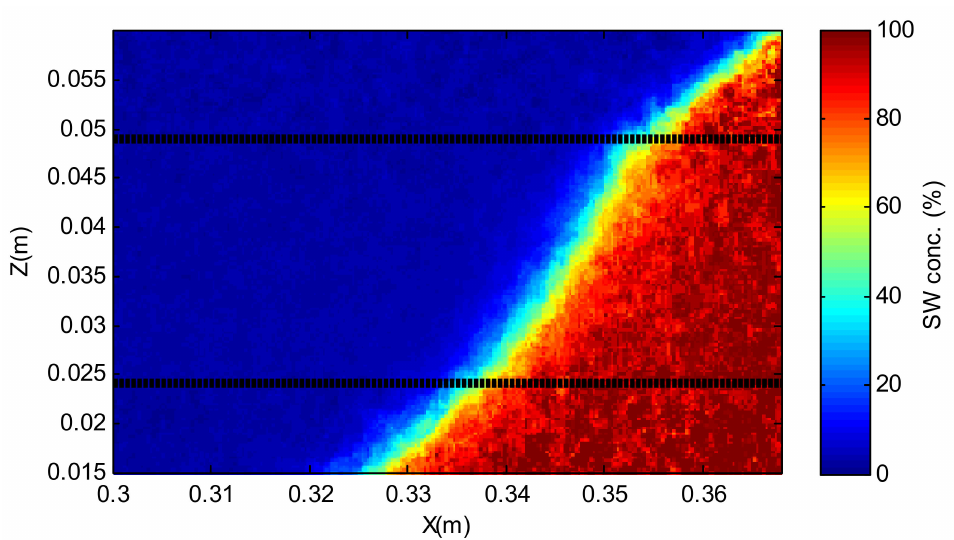
Figure 7. Experimental Layered-2 (H-L-H) interface showing larger mixing zone in low permeabil- ity